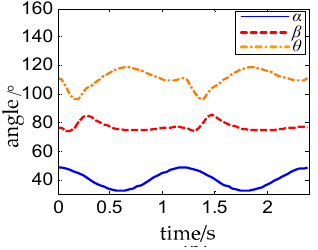
Figure 15. Trajectory planning of the knee and ankle joints.